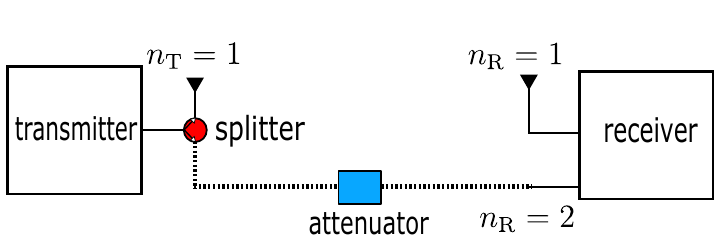
Figure 5. 1 × 2 single-input multiple-output (SIMO) configuration describing the implementation of simplified CSI calibration technique in Equation